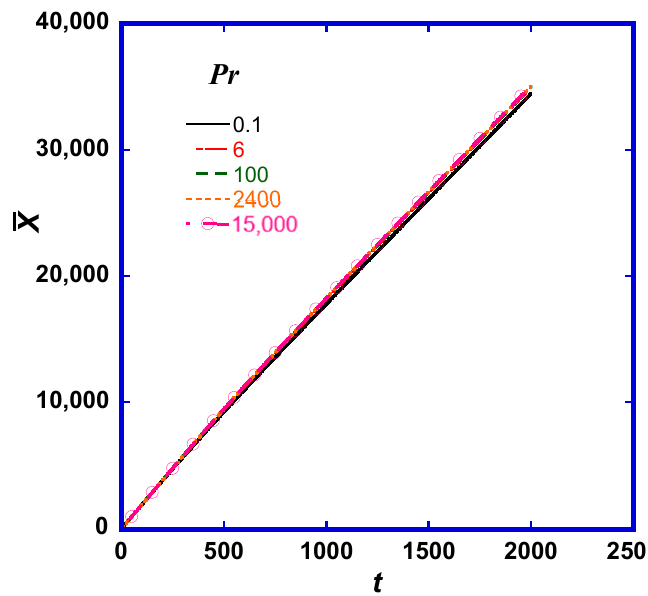
Figure 1. Mean streamwise position (in viscous wall units) of particles released instantaneously from a point source at the center of a turbulent flow channel. The slope of the lines changes from representing the maximum mean fluid velocity at small times to representing the bulk fluid velocity in the channel at longer times.